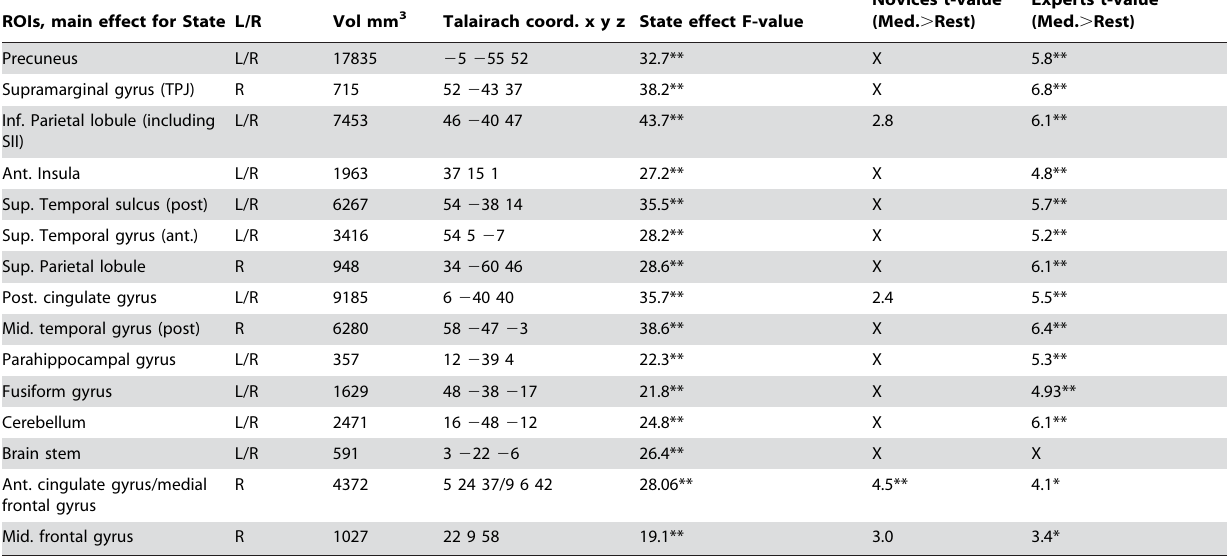
Table 3. Main effect for State.